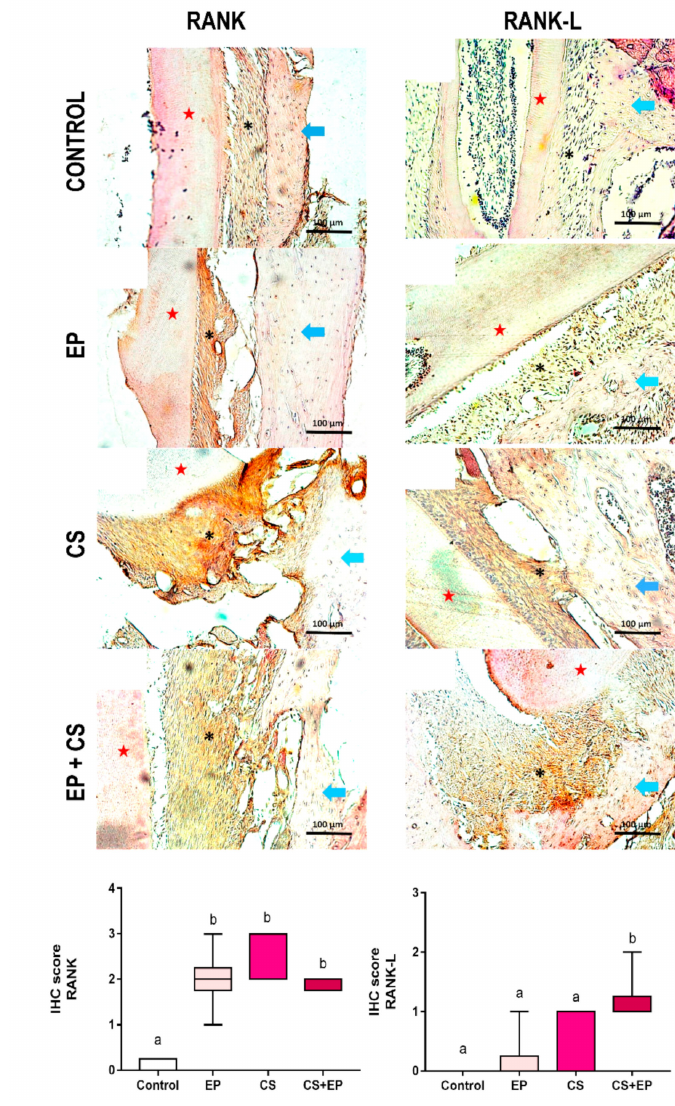
Figure 3. E ff ects of experimentally induced chronic immobilization stress and ligature-induced periodontitis on RANK and RANK-L expression of the alveolar bone (blue arrows) of male Wistar rats (90-days-old, n = 28). Representative photomicrographs of the control group; experimental periodontitis group (EP); chronic stress group (CS); and chronic stress and experimental periodontitis group (CS + EP). Results are expressed as mean ± standard error of immunohistochemistry score (IHC score) of RANK and RANKL expression. Kruskal–Wallis test, p < 0.05. Similar overwritten letters did not reveal statistically significant di ff erences. EP: ligature-induced experimental periodontitis group; CS: chronic stress by physical restraint model; CS + EP: association of chronic stress and ligature-induced periodontitis. Scale bar: 100 µ m. Cementum ( (cid:70) ) and periodontal ligament